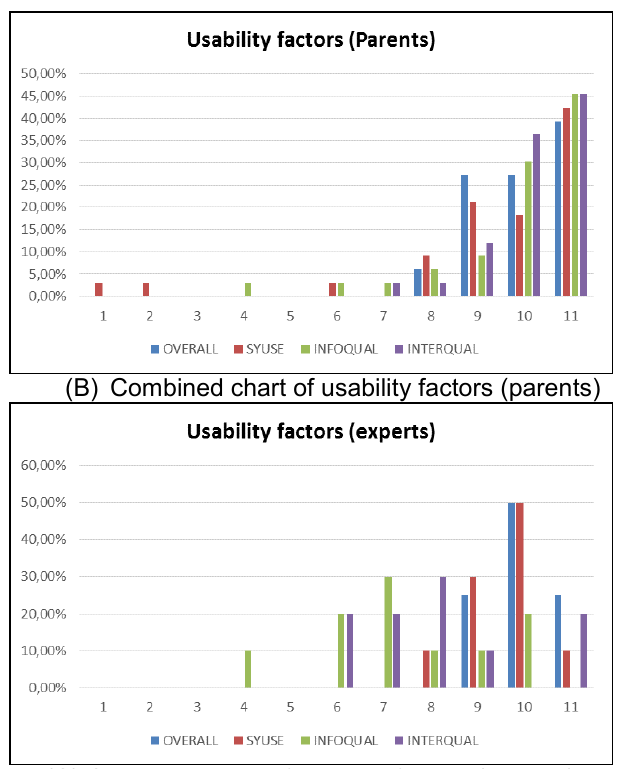
Figure 10. Evaluation